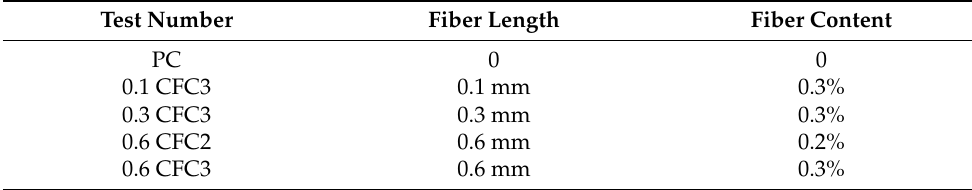
Figure 4. Schematic diagram of the basic test device. Table 1. Microwave deicing test